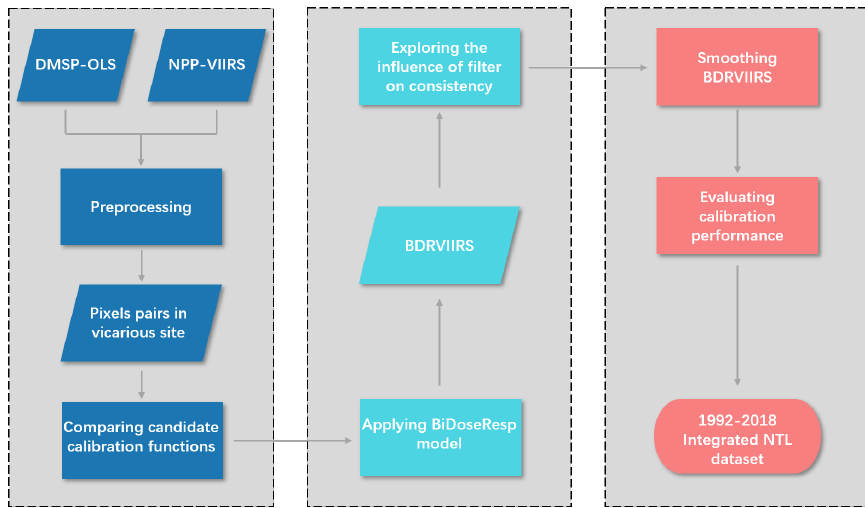
Table 1. Properties of Defense Meteorological Satellite Program’s Operational Linescan System (DMSP-OLS) and National Polar-orbiting Partnership Satellite’s Visible Infrared Imaging